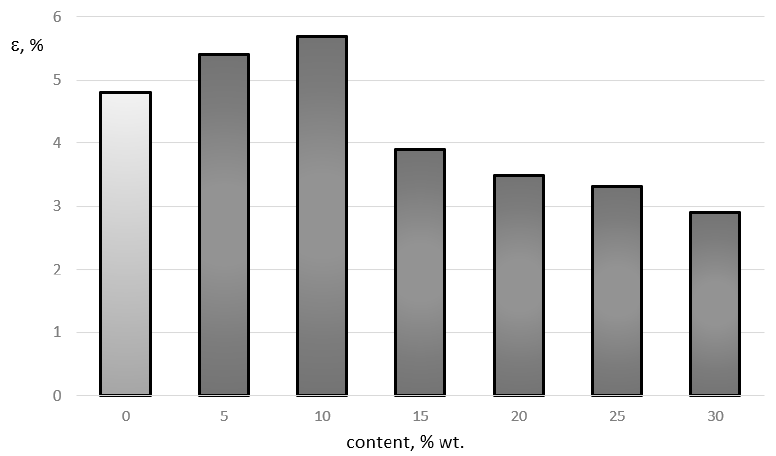
Figure 2. Change of elongation at break depending on the content of the Crusil M20 filler.